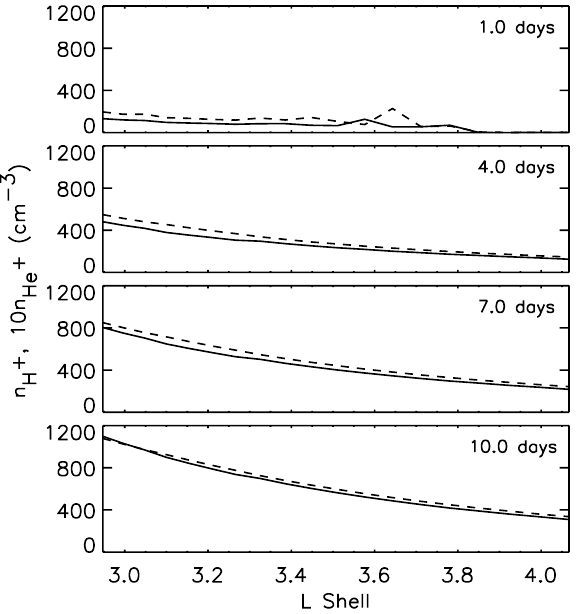
Fig. 4. H + (solid line) and He + (dashed line) densities versus L- shell at the magnetic equator, with the He + density scaled up by a factor of 10, for various times after the storm.